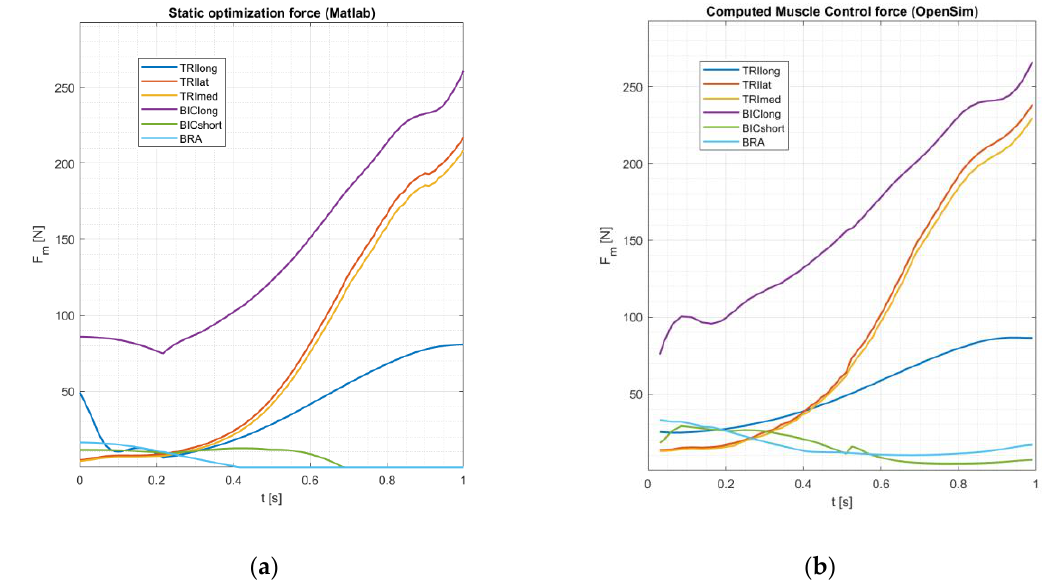
Figure 18. Muscles’ forces with physiological criterion and passive forces: ( a ) Matlab and ( b ) OpenSim.